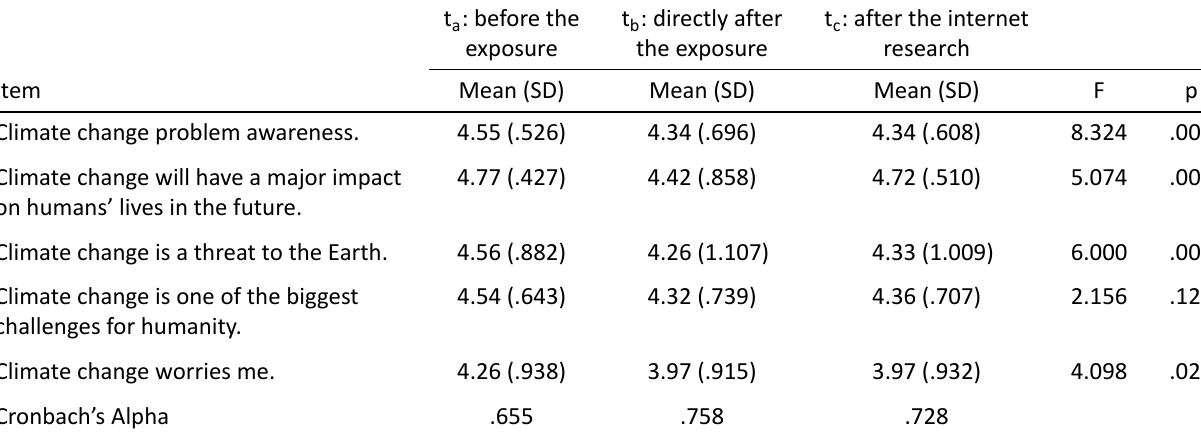
t : before the t : directly after t : after the internet a b c exposure the exposure